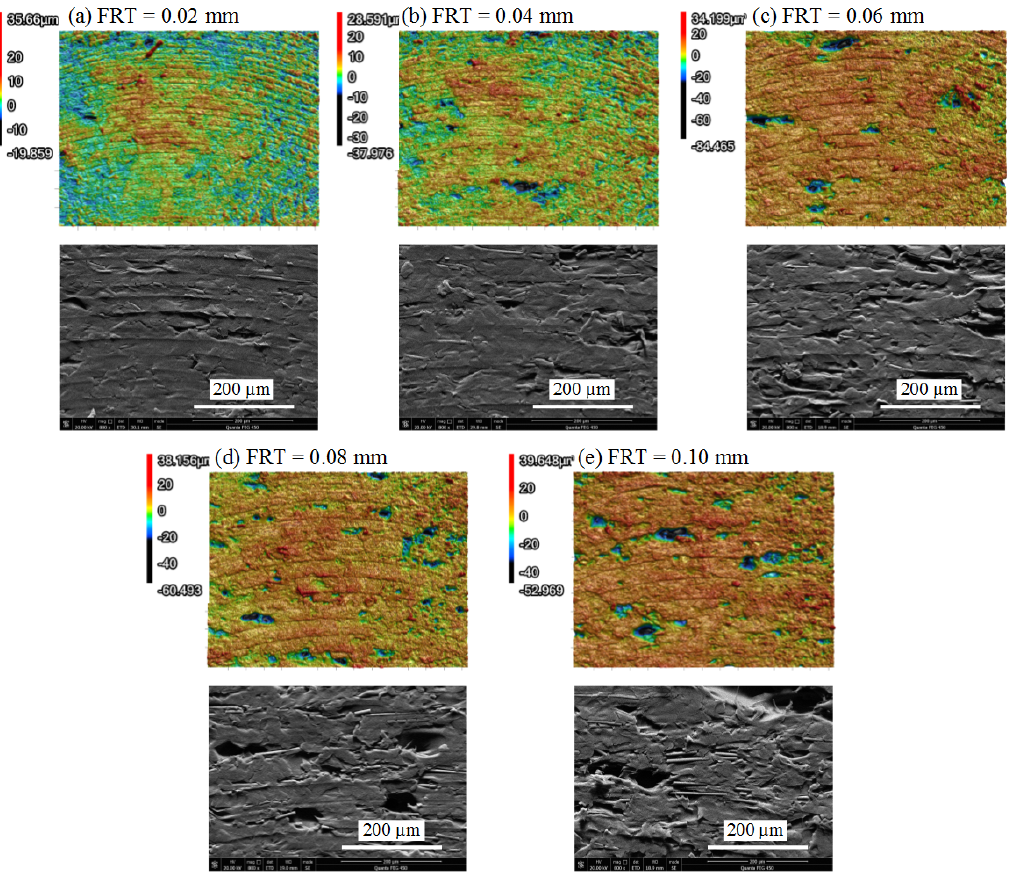
Figure 15. 3D morphologies comparison of CF/PEEK parts under different FRTs (RA = 90 ° , LT = 0.1 mm, SS = 5000 r/min): ( a ) FRT = 0.02 mm; ( b ) FRT = 0.04 mm; ( c ) FRT = 0.06 mm; ( d ) FRT = 0.08 mm; ( e ) FRT = 0.10 mm.